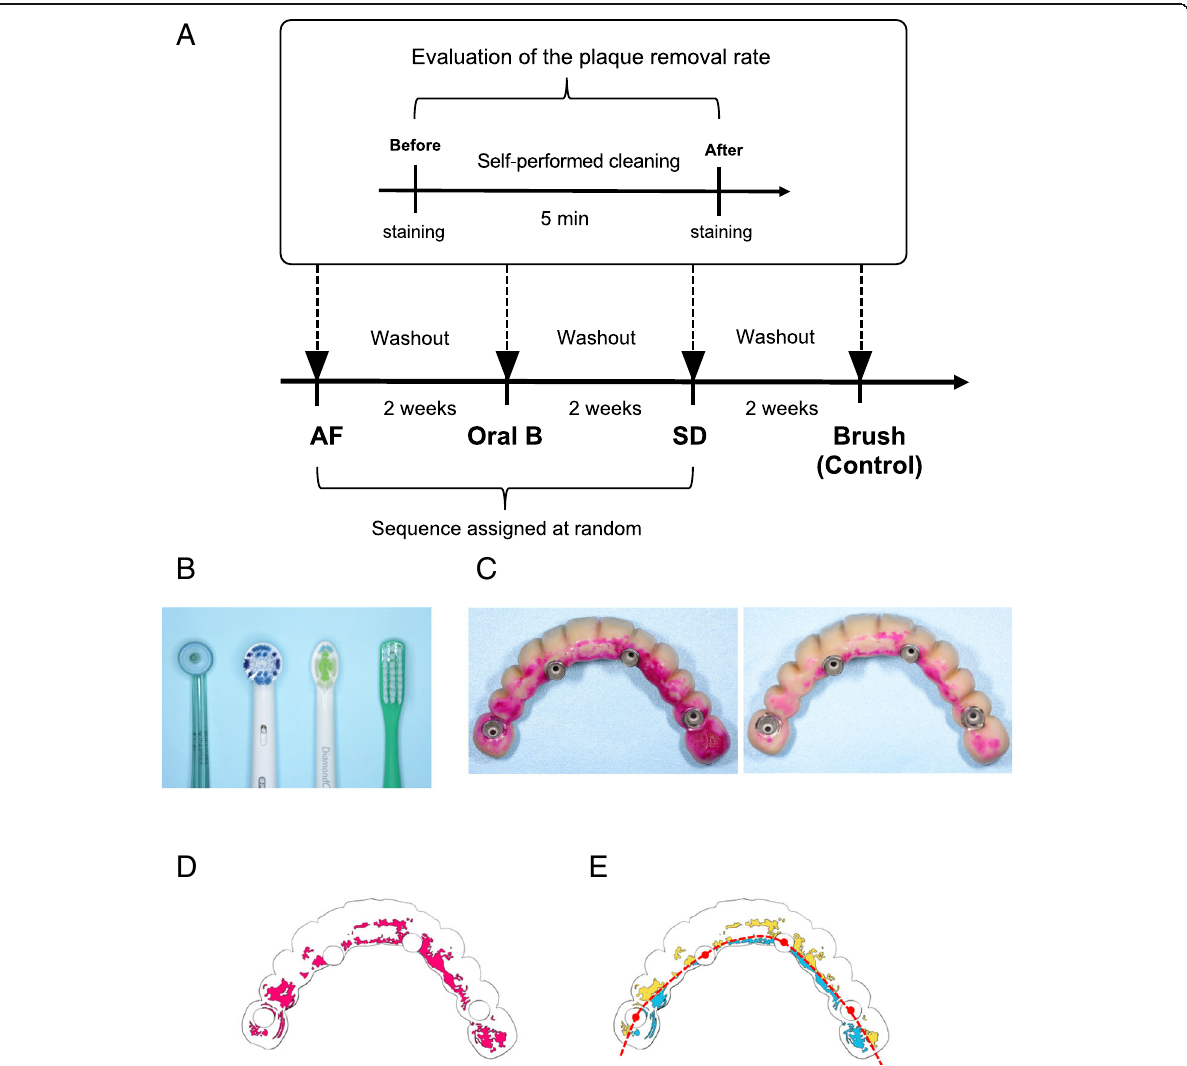
Fig. 1 Study design and digital images for the comparison of four different tooth-cleaning instruments. a Each patient was randomly assigned to use two electric-powered brushes (OralB and SD) and one electric dental floss unit (AF). A manual toothbrush was used for the control group. b Brush heads of each instrument. From left to right: AF (nozzle HX8002/05), OralB (brushing head EB20), SD (brushing head HX6074/05), and Brush (Tuft24® MS). c Left: fitting surface of an implant-supported FDP before brushing; right: after brushing. Plaque is stained red. d The plaque area and the outline of the FDP in c were traced manually, and the plaque was colored with pink to calculate the area before and after brushing (only after brushing is shown in the figure). e The plaque area in d was divided into buccal and palatal sides with a dotted line that passes through the center points of each of the four implants ’ midpoints. The yellow area denotes buccal side plaque, and the light blue area denotes